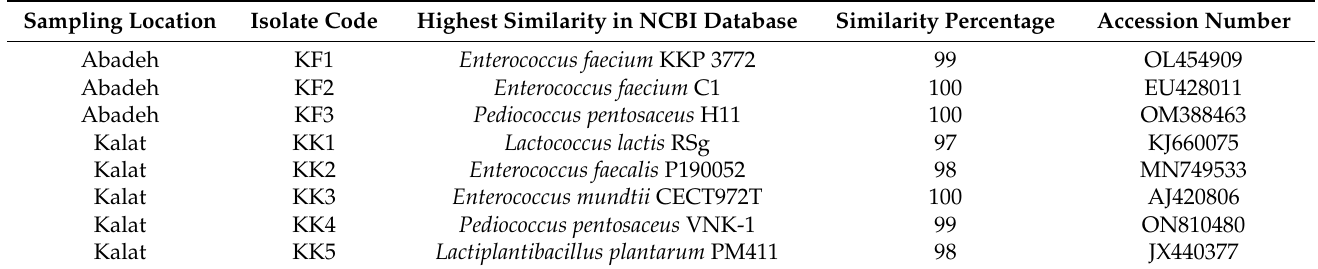
Table 2. Identification of LAB isolates of Abadeh (Fars) and Kalat (Razavi Khorasan) kashk samples using a molecular